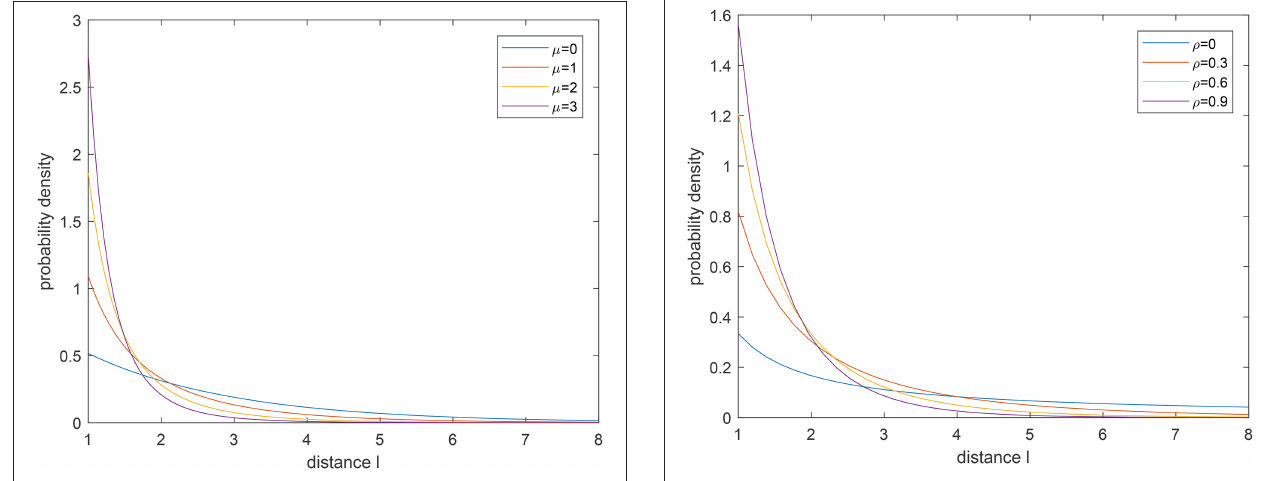
FIGURE 3 | Probability density for tempered Lévy distribution with µ = 1 for different ρ